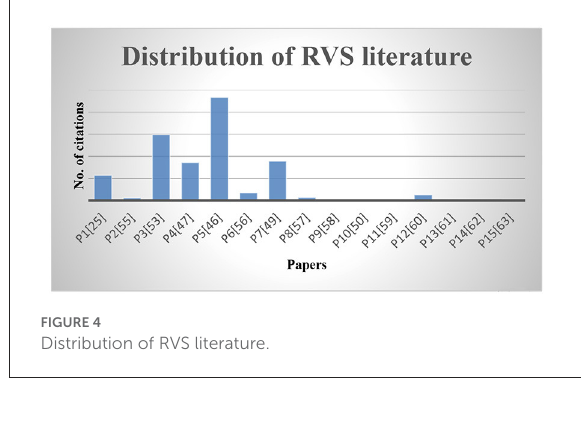
FIGURE4 Distribution of RVS literature.